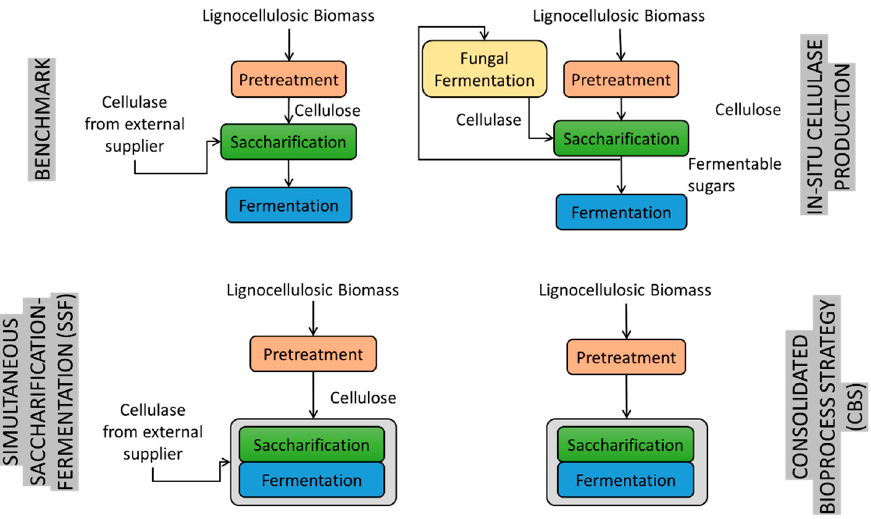
Figure 3. Strategies for lignocellulose saccharification and fermentation of lignocellulosic sugars [9,37].